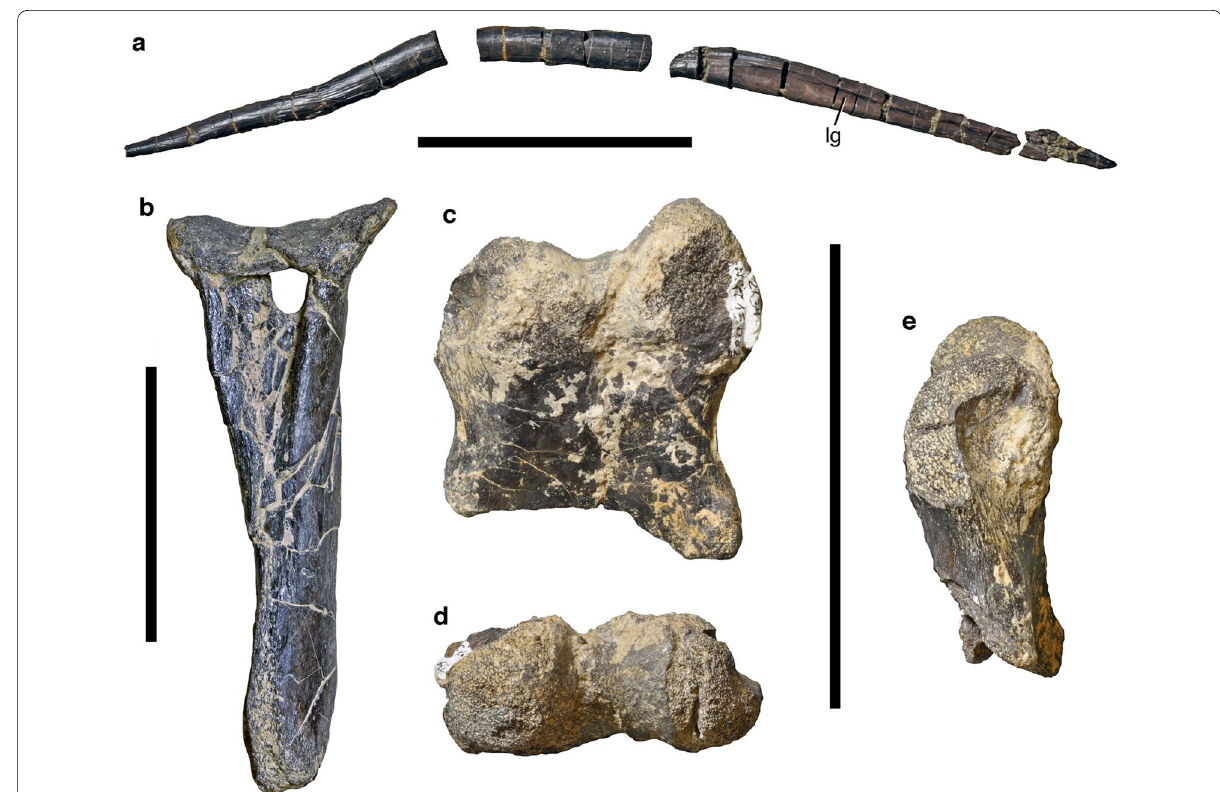
Fig. 15 Sauropodomorph material resulting from the recent excavation at Schleitheim-Santierge. a gastral rib, MzA NAT15106, in dorsal or ventral view; b chevron, MzA NAT15081, in posterior view; c – e right metacarpal I, MzA NAT15082, in dorsal ( c ), distal ( d ) and medial ( e ) view. lg, longitudinal groove. Scale bars equal 10